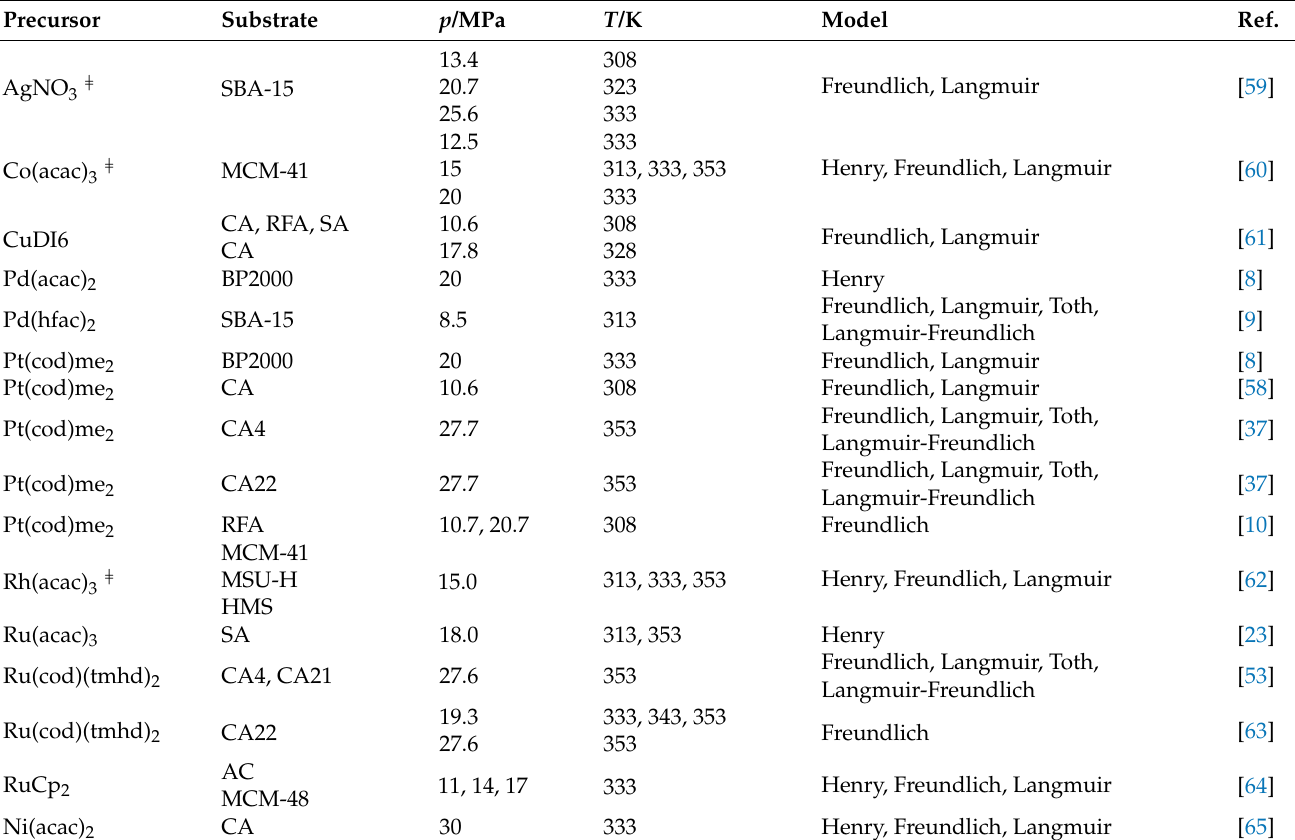
Table 4. Summary of experimental adsorption data from literature considered and models applied within this review ( } experiments conducted with